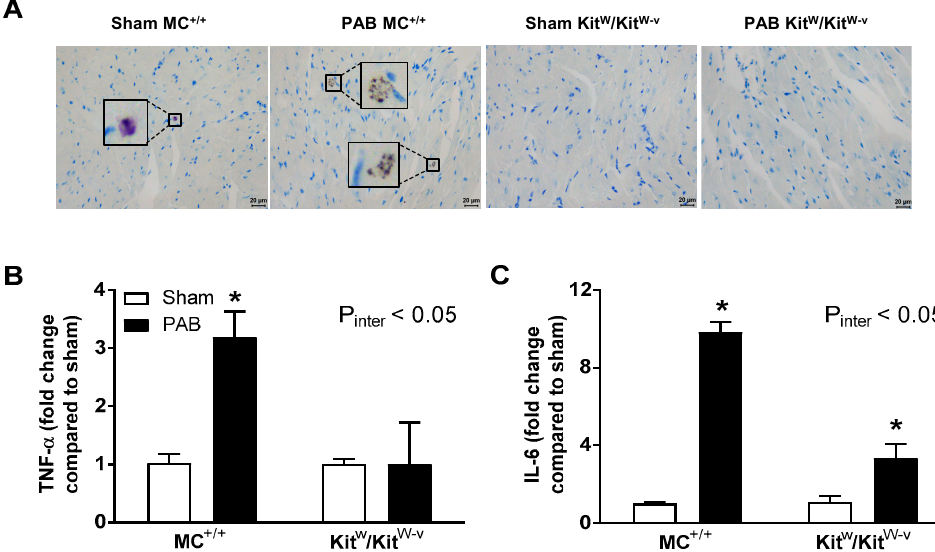
Figure 4. Attenuated inflammatory responses in the pressure-overloaded right ventricles of MC +/+